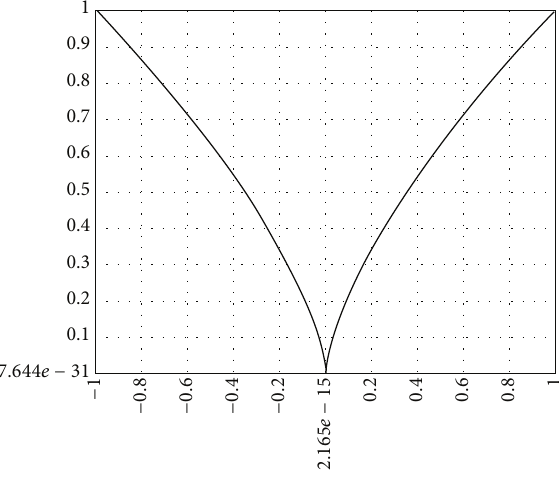
Figure 2: Vector-function g (𝑡) = (𝑡 2 ,𝑡 3 ) and fractal interpolation vector-function g ⋆ completely